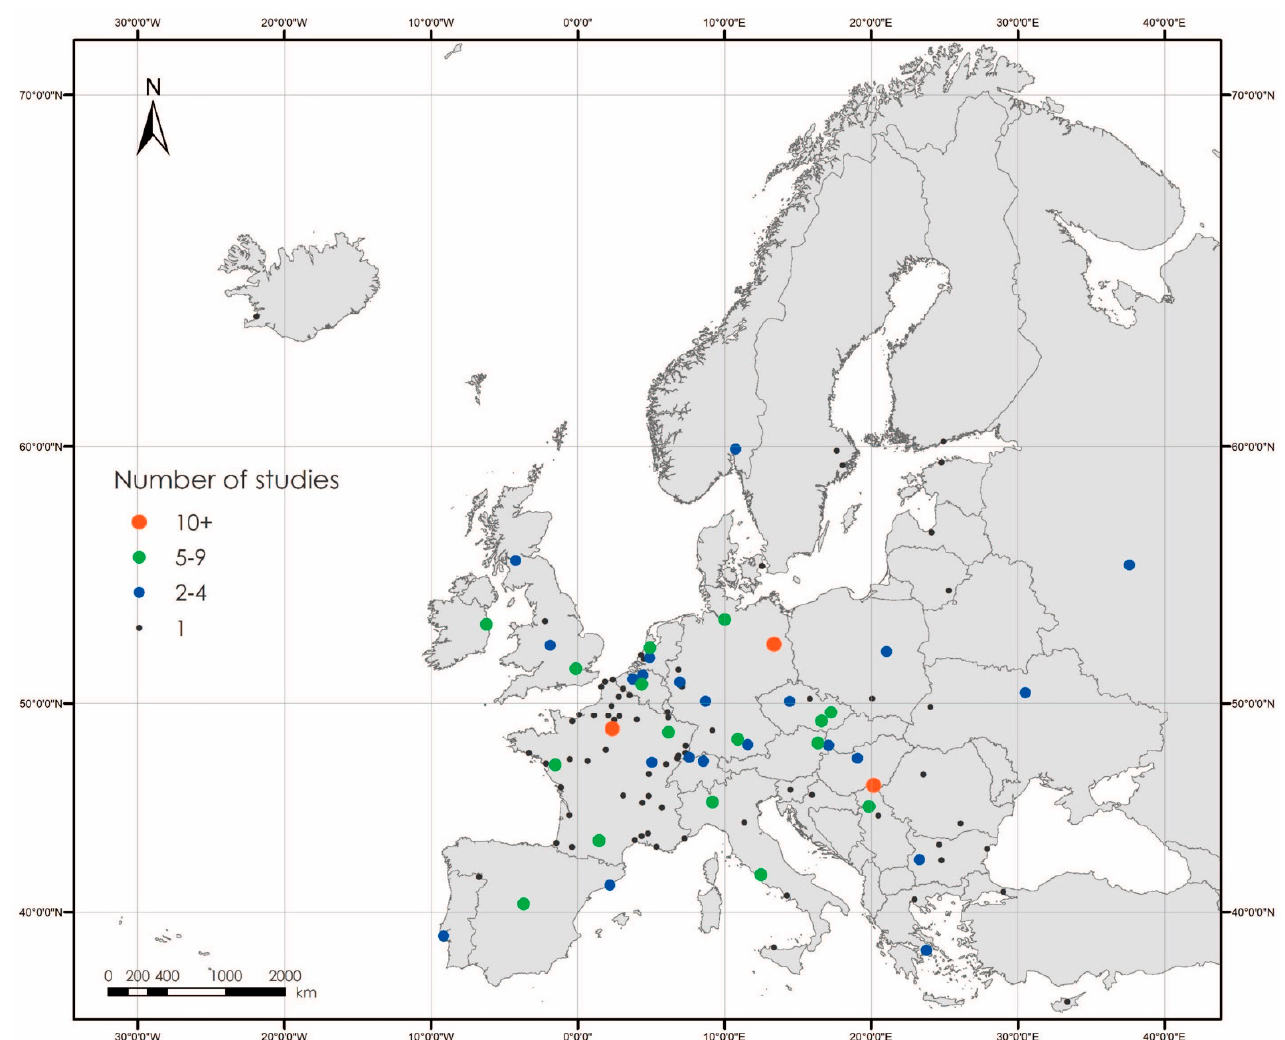
Figure 5. Geographical extent of the study areas identified within Europe.